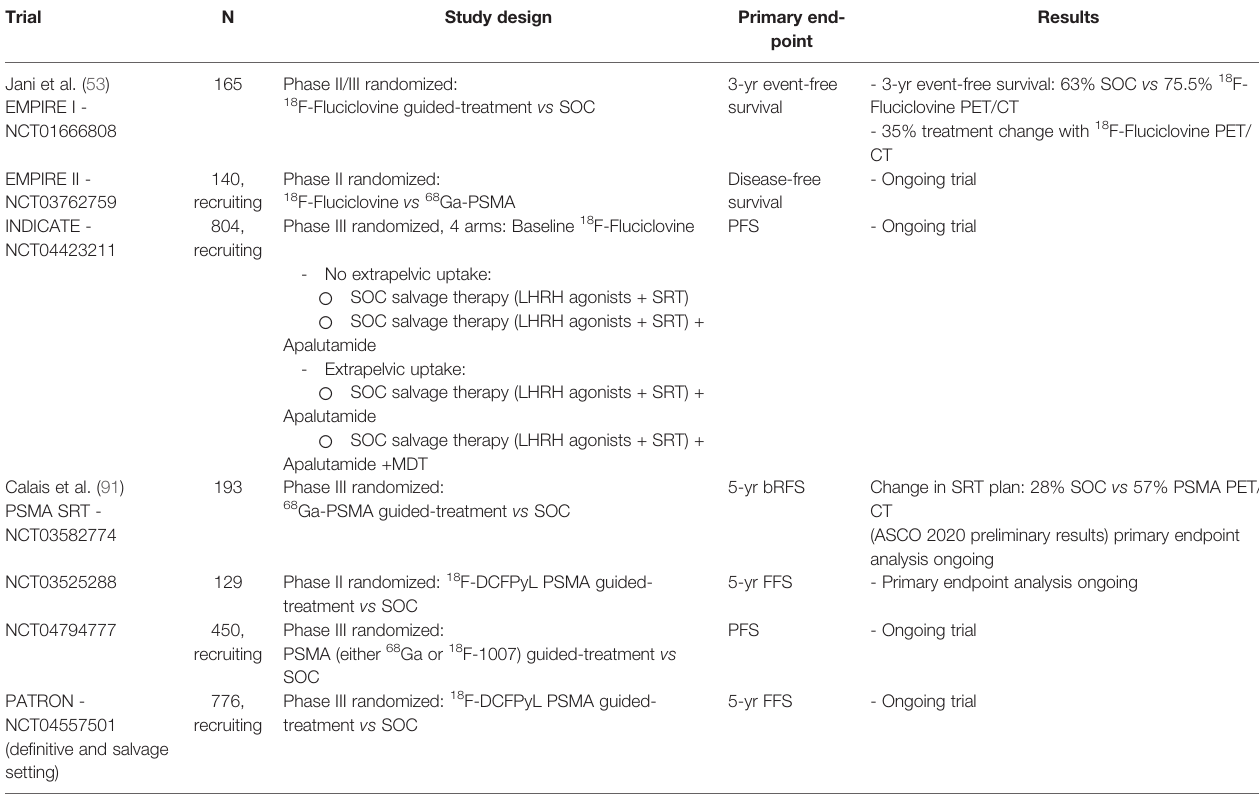
PSMA, prostate speci fi c membrane antigen; SOC, standard of care; SRT, salvage radiotherapy; bRFS, biochemical relapse free-survival; RP, radical prostatectomy; MDT, Metastasis Directed Therapy; PFS, Progression Free Survival; LHRH, Luteinizing Hormone Releasing Hormone; FFS, Failure-Free